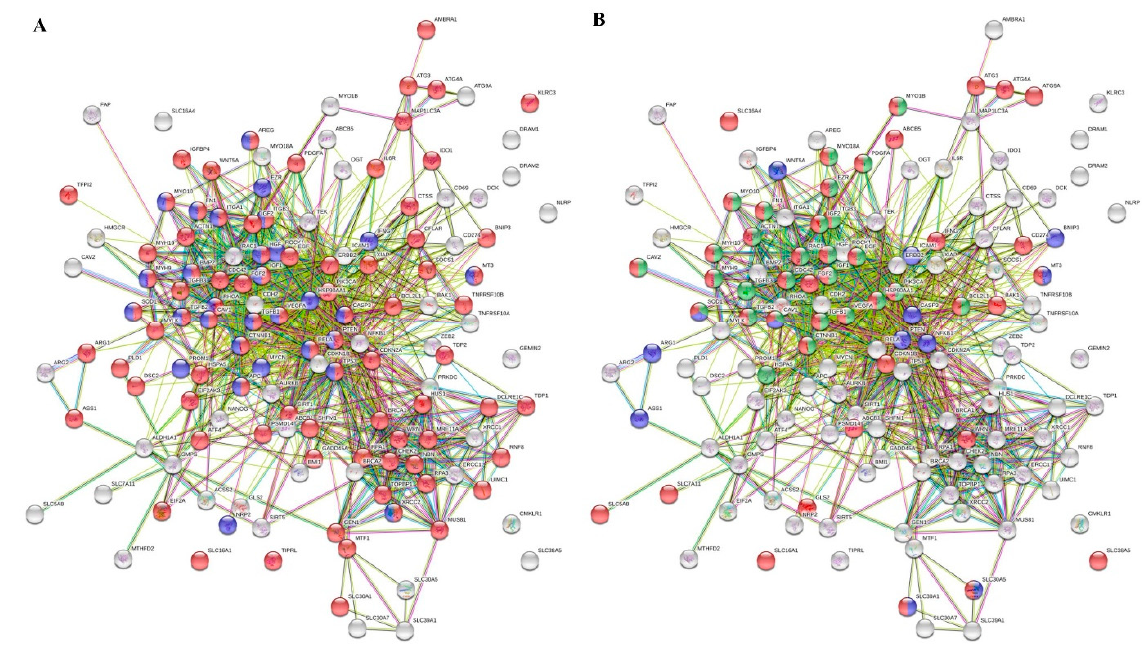
Figure 4. Interactome networks of genes up-regulated in UKF-NB-4 CDDP cells. ( A ) The red and blue nodes highlight the genes, which are involved in response to DNA repair and neurogenesis, respectively. ( B ) The red, green and blue nodes highlight the genes, which are involved in metal ion transport, vesicles-mediated transport and response to metal ions, respectively. The color of the line provides evidence of the different interactions among translated proteins. A red line indicates the presence of fusion evidence; a green line, neighborhood evidence; a blue line, concurrence evidence; a purple line, experimental evidence; a light blue line, database evidence; a black line, co-expression evidence.